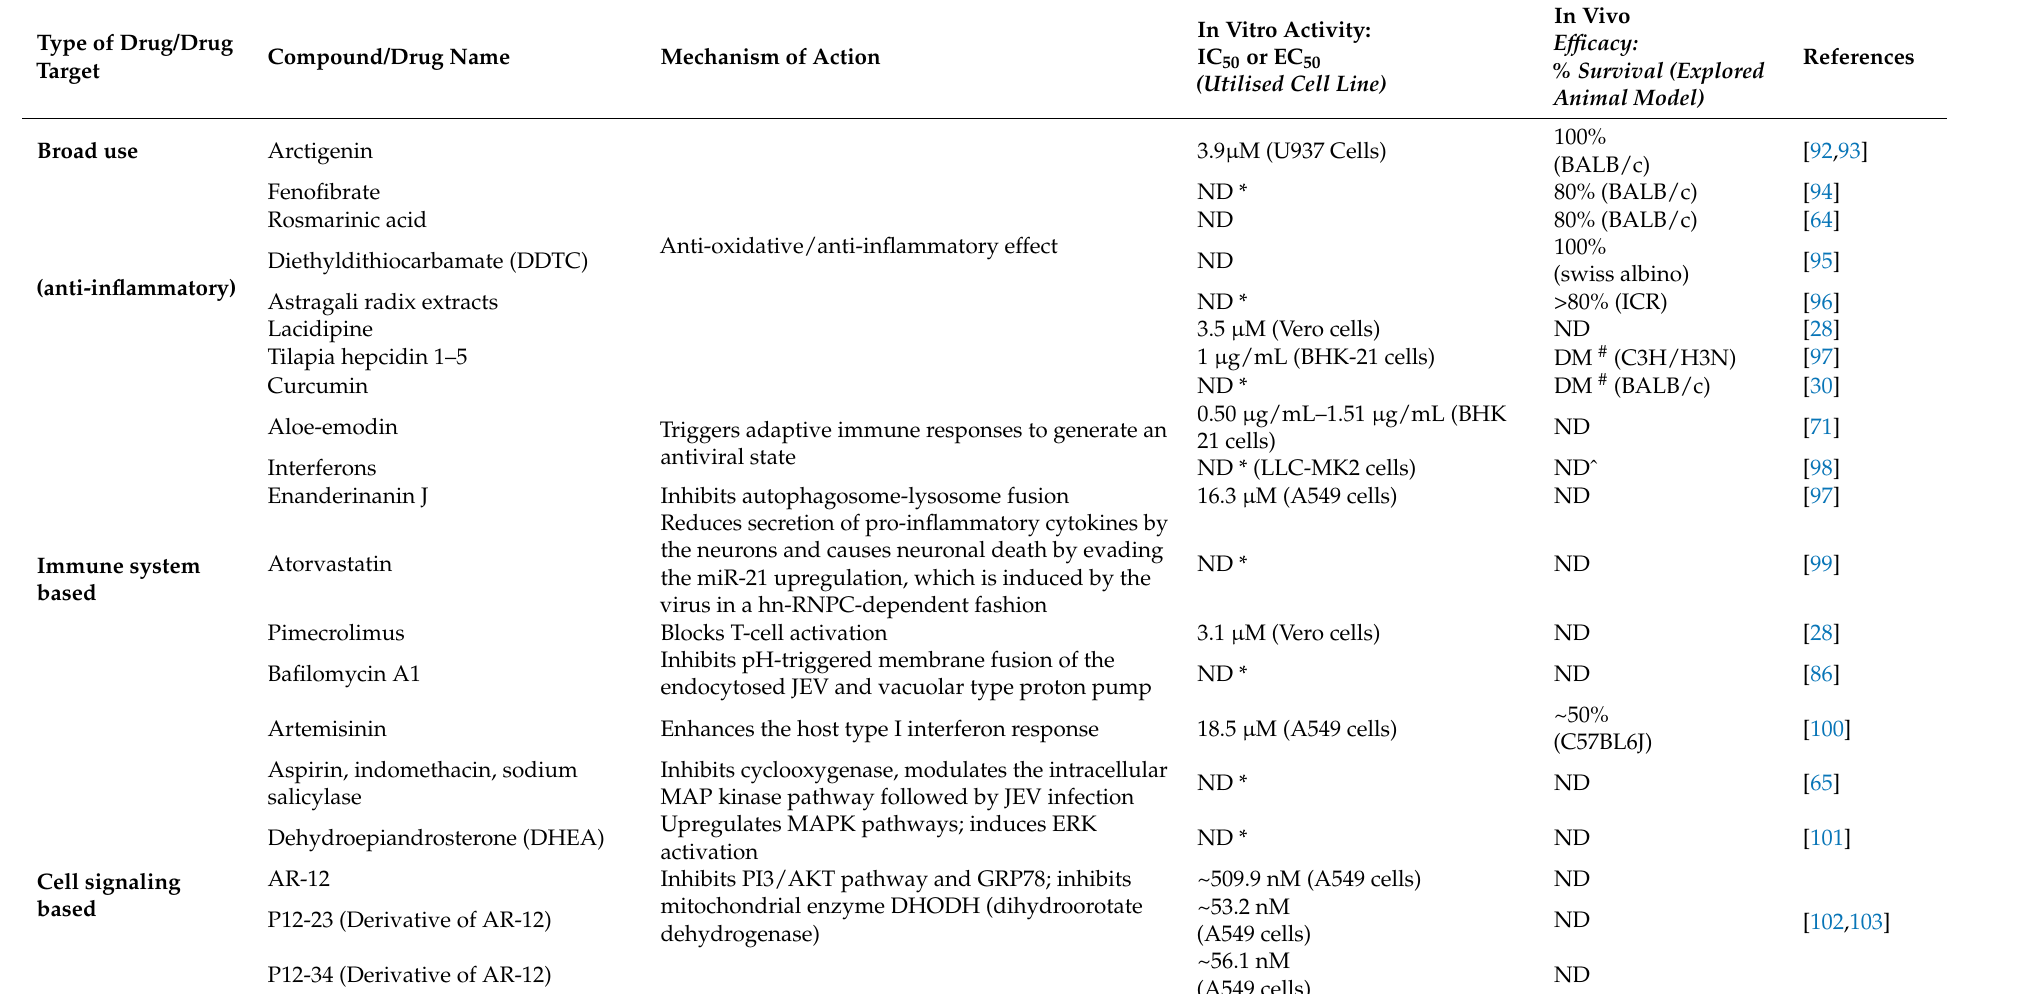
Table 1. Antivirals being explored against